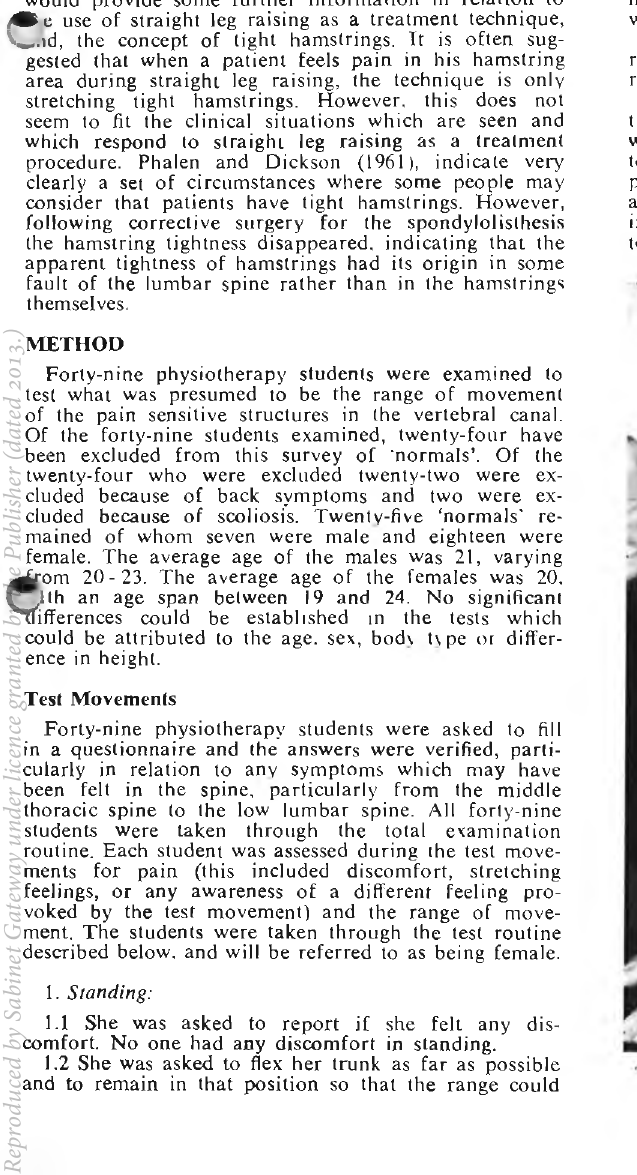
Fig. 1. ‘Slump-sitting’ wilh